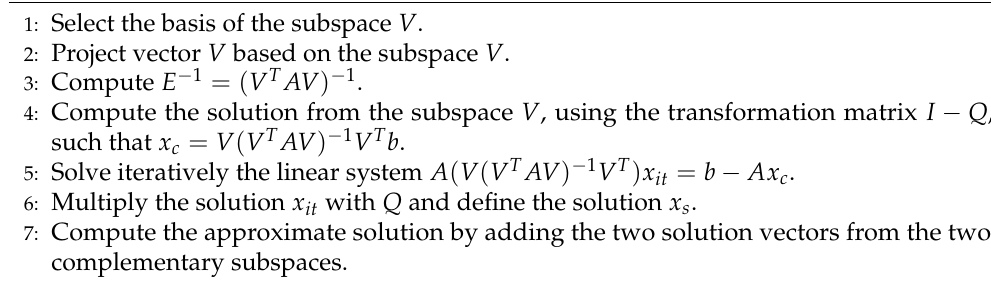
Algorithm 1 Deflation technique for solving linear